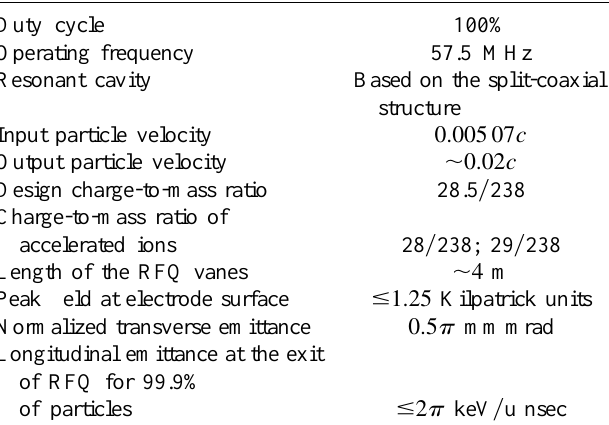
TABLE I. Initial requirements for RFQ